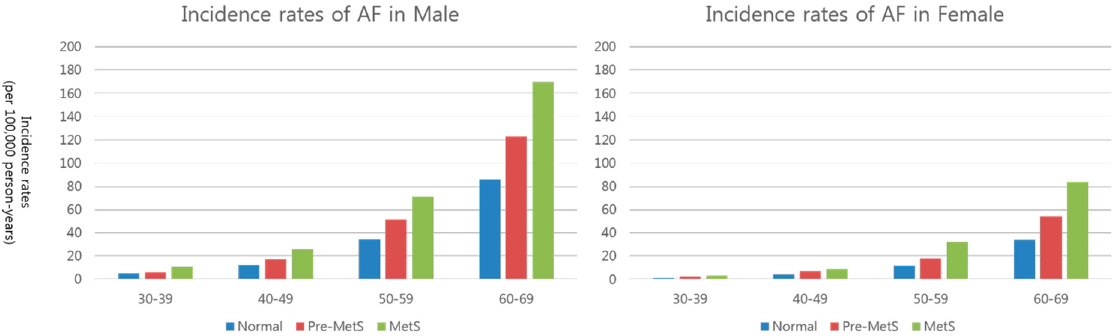
Figure 2. Association between metabolic syndrome status and risk of atrial figure according to patient sex and age. Subjects with pre-MetS or MetS have an increased risk of new-onset AF in all groups.